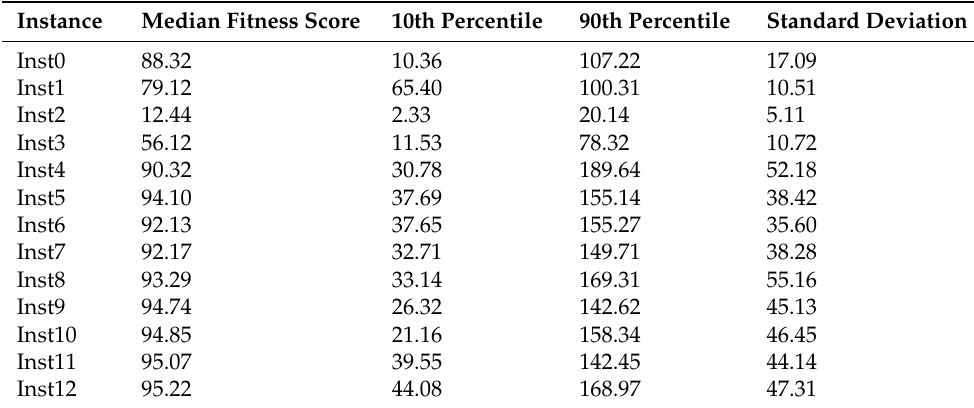
Table 4. Results for the FLC